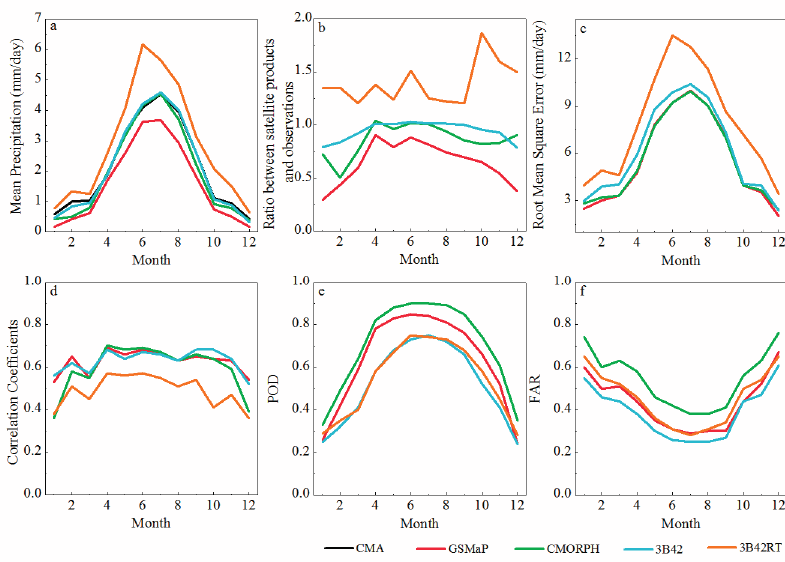
Figure 3. Seasonal variations of validation statistics. ( a ) Mean precipitation (mm/day); ( b ) ratio between satellite products and observations (%); ( c ) RMSE (mm/day); ( d ) Correlation coefficients; ( e ) POD and ( f )